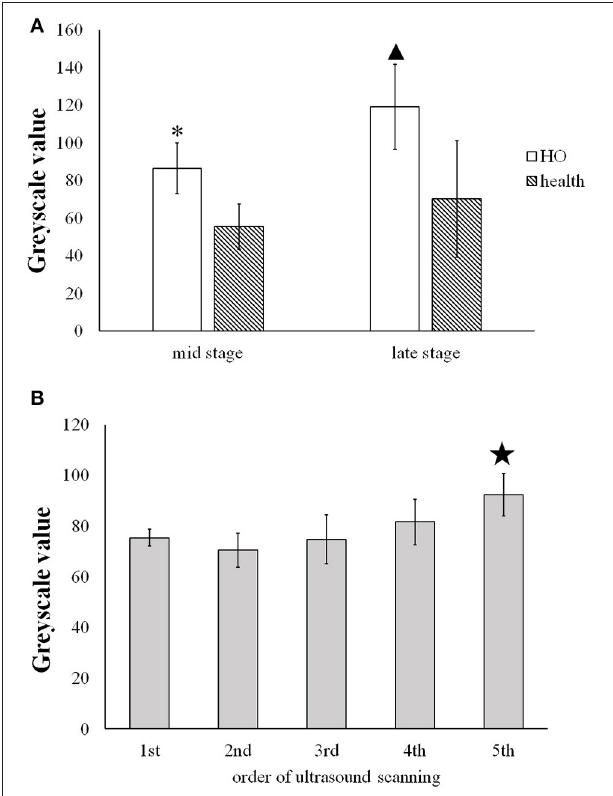
FIGURE 5 | (A) Comparison of the greyscale value of the HO tissues and the health muscle tissues at the middle and late stage. * and present the statistically significant difference between HO and health muscle ( p < 0.001). (B) Comparison of the grayscale value of HO measured on five time spots during the development of